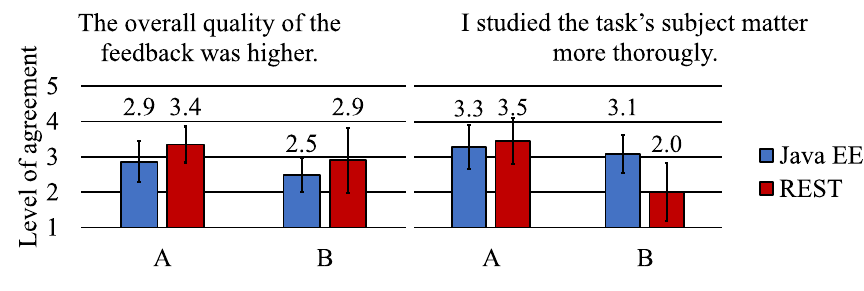
Fig. 2. Feedback quality and student